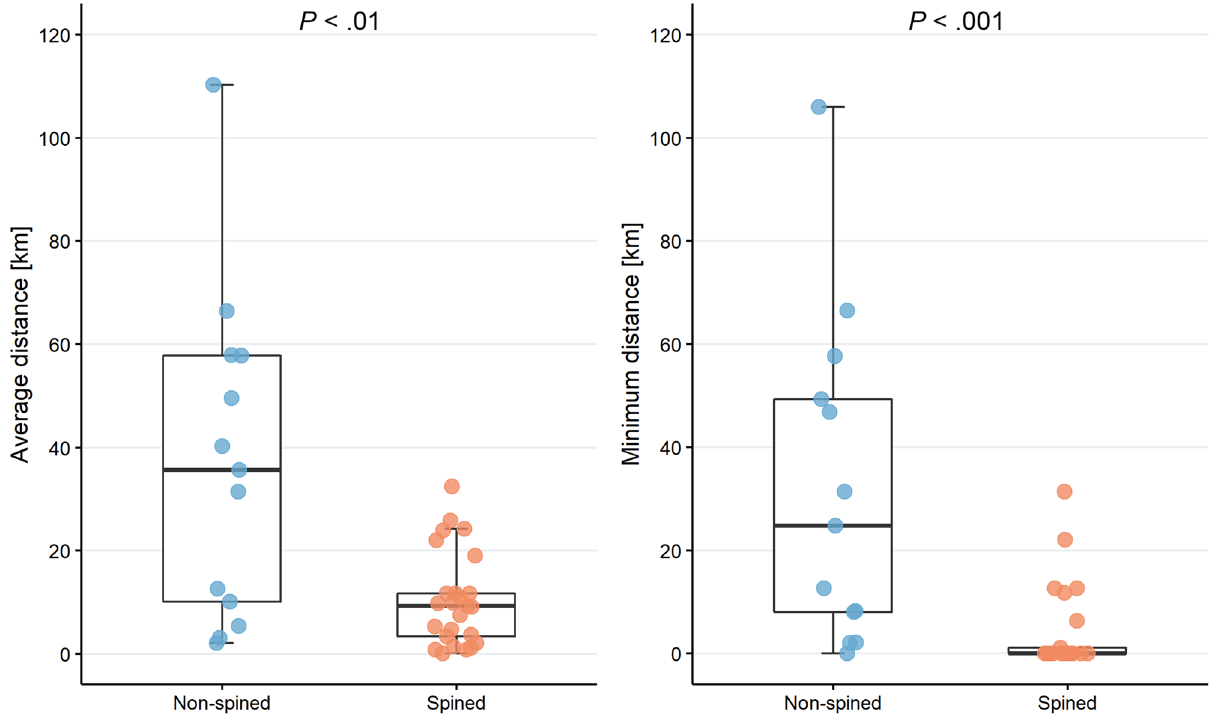
Figure 3. Average (left) and minimum (right) distances of lake Niphargus localities to the nearest olm locality by species. Differences between non-spined (n = 13) and spined (n = 38) lake species were assessed with the Kruskal–Wallis rank sum